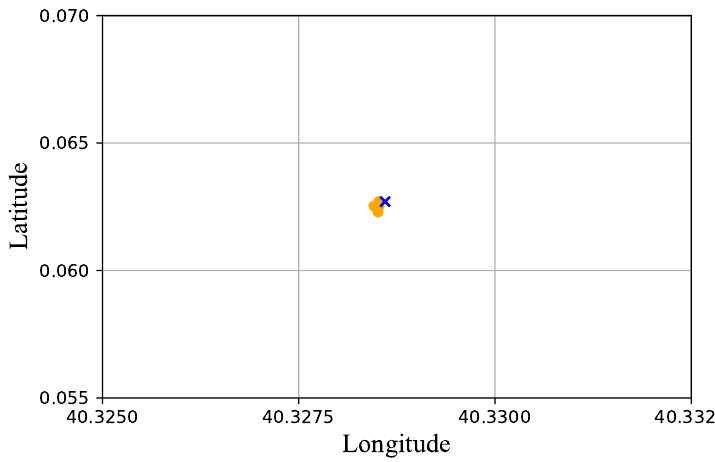
Figure 1. Diagram of the relationship between a shop and customer latitude and longitude.